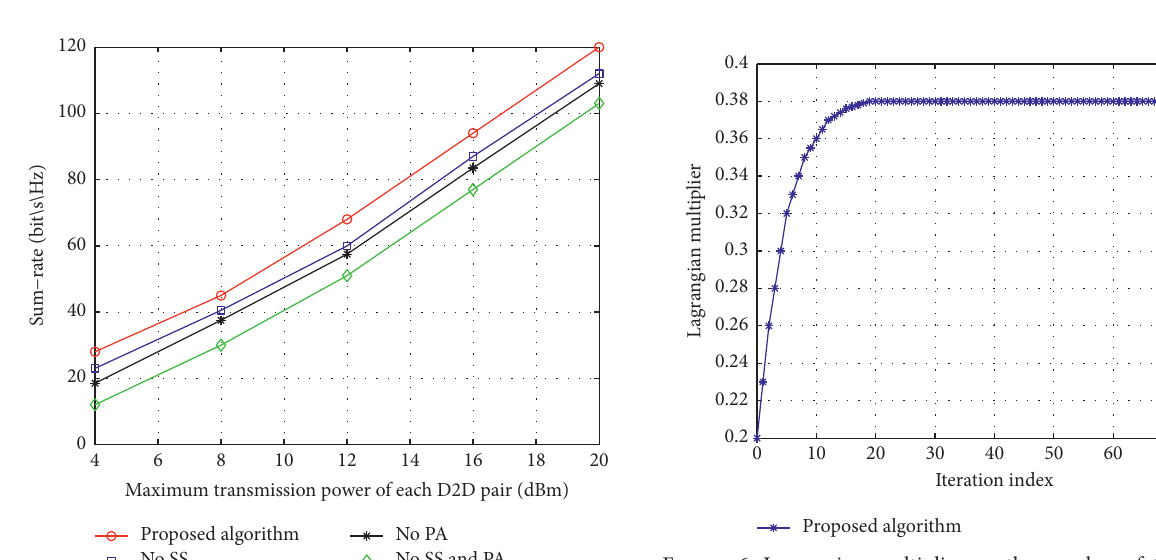
Figure 6: Lagrangian multiplier vs. the number of the iterative index.